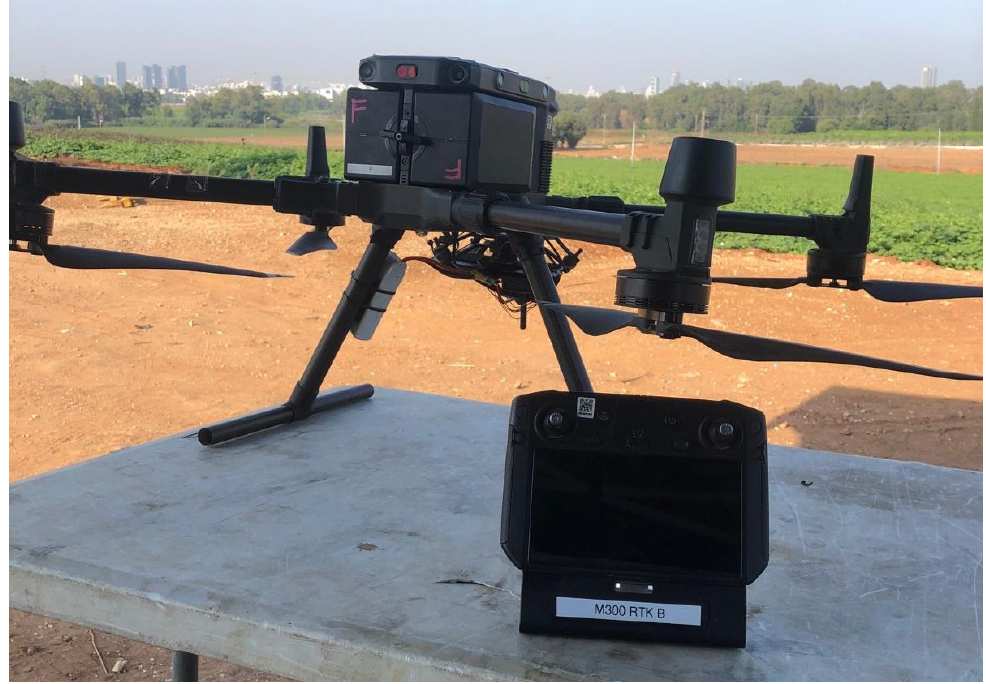
Figure 6. DJI Matrice 300 RTK used in the field